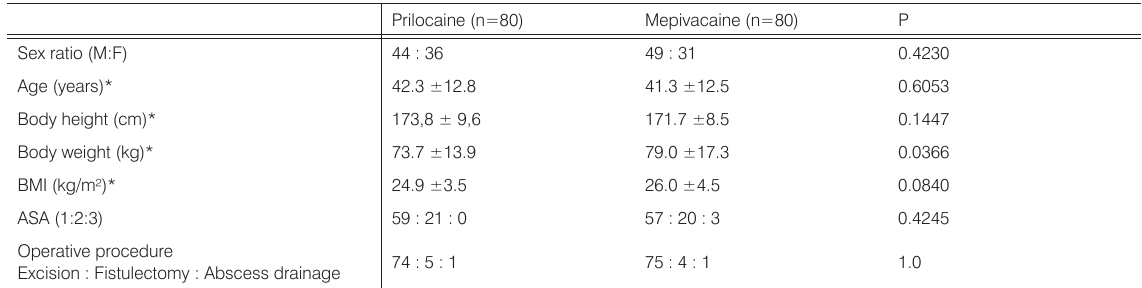
Table 2. Demographic data of patients receiving a spinal anaesthesia with prilocaine or mepivacaine. *Values are mean ±SD; BMI, body mass index; ASA, American Society of Anaesthesiologists Prilocaine